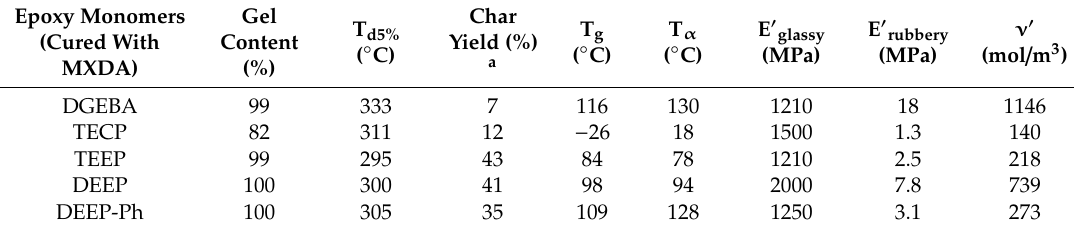
Table 1. Thermal and thermo-mechanical properties of cured